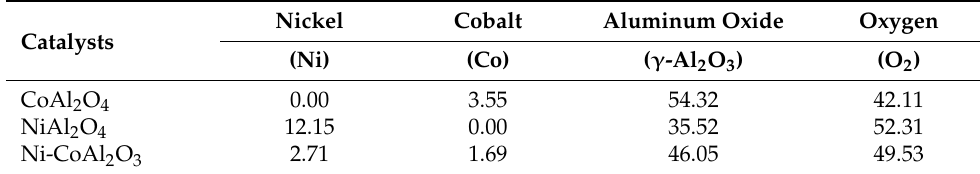
Figure 12. Morphological structure of Ni-CoAl 2 O 3 obtained from TEM. Table 4. The chemical composition content of the obtained catalysts.